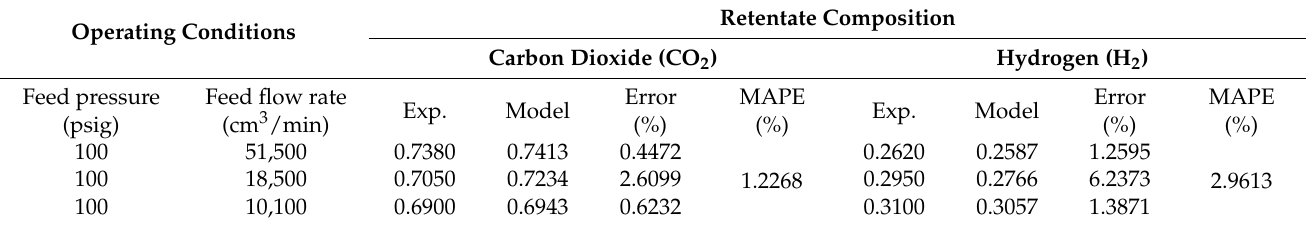
Table 5. Comparison between experimental [32] and modeled values for gas separation using spiral wound membranes.